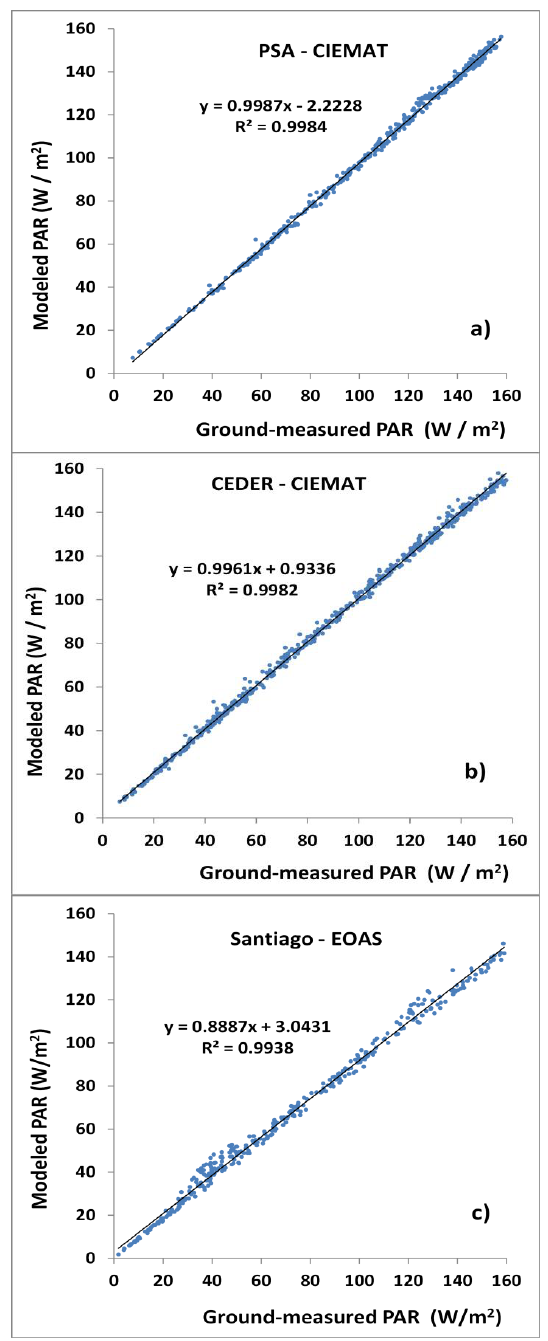
Figure 4. Correlograms for validation stations: ( a – c ) correspond to PSA-CIEMAT, CEDER-CIEMAT, and Santiago-EOAS stations, respectively.